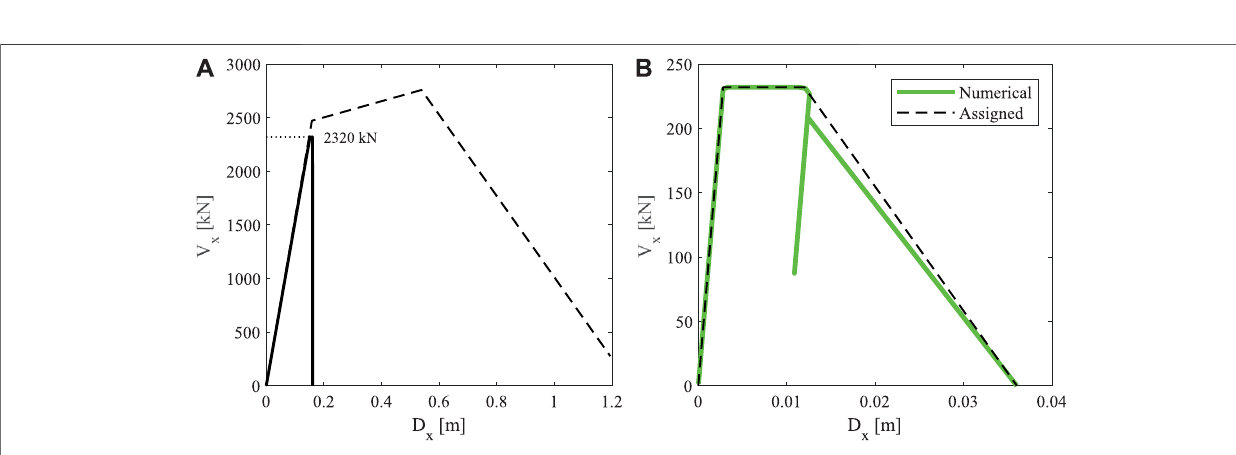
Frontiers in Built Environment |